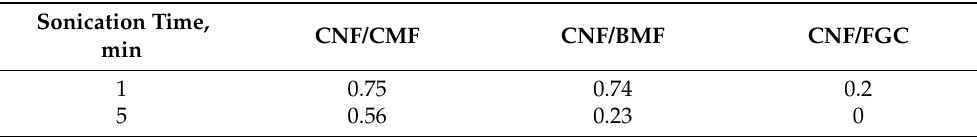
Table 2. The coating coefficient ( k c ) values calculated from TEM images for the hierarchical materials studied in the present